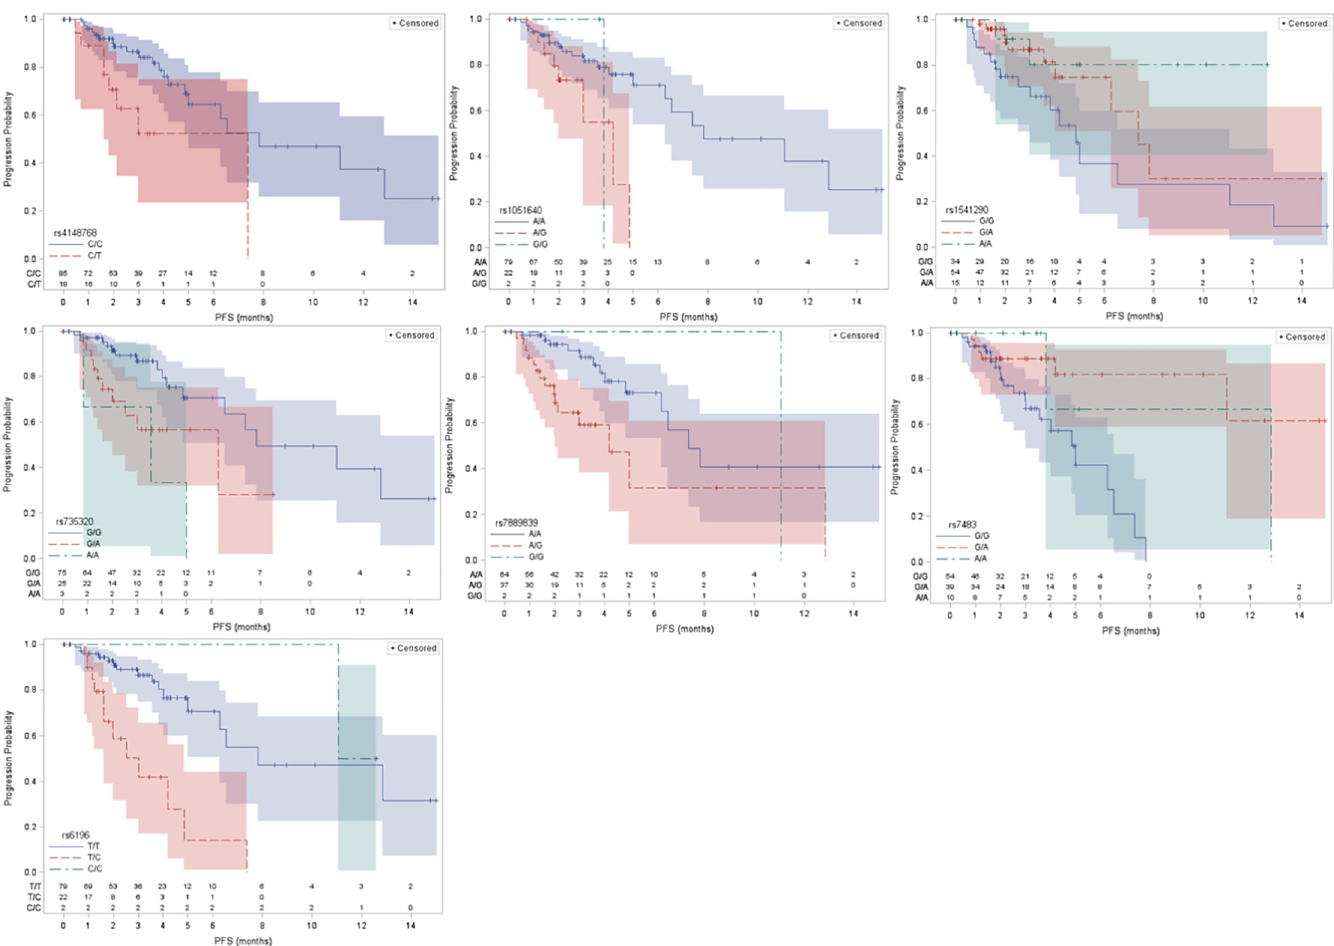
Fig 1. Kaplan-Meier plots of potentially important associations following Cox regression analyses. Paclitaxel PFS was related to genetic variants in seven genes: A) ABCB11 rs4148768, B) ABCC3 rs1051640, C) ABCG1 rs1541290, CYP8B1 rs735320, FMO6P rs7889839, GSTM3 rs7483, and NR3C1 rs6196.